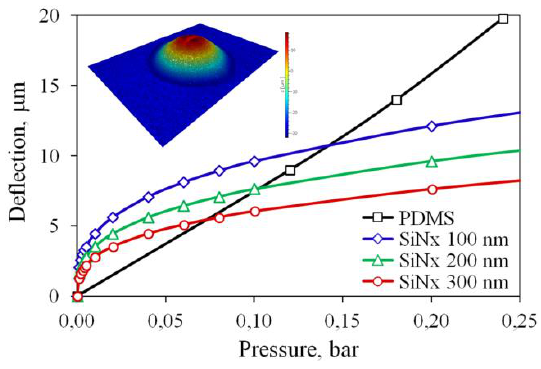
Figure 2. Membrane deflection as a function of the overpressure in the chamber. The inset shows the PDMS membrane shape measured by the vibrometer.